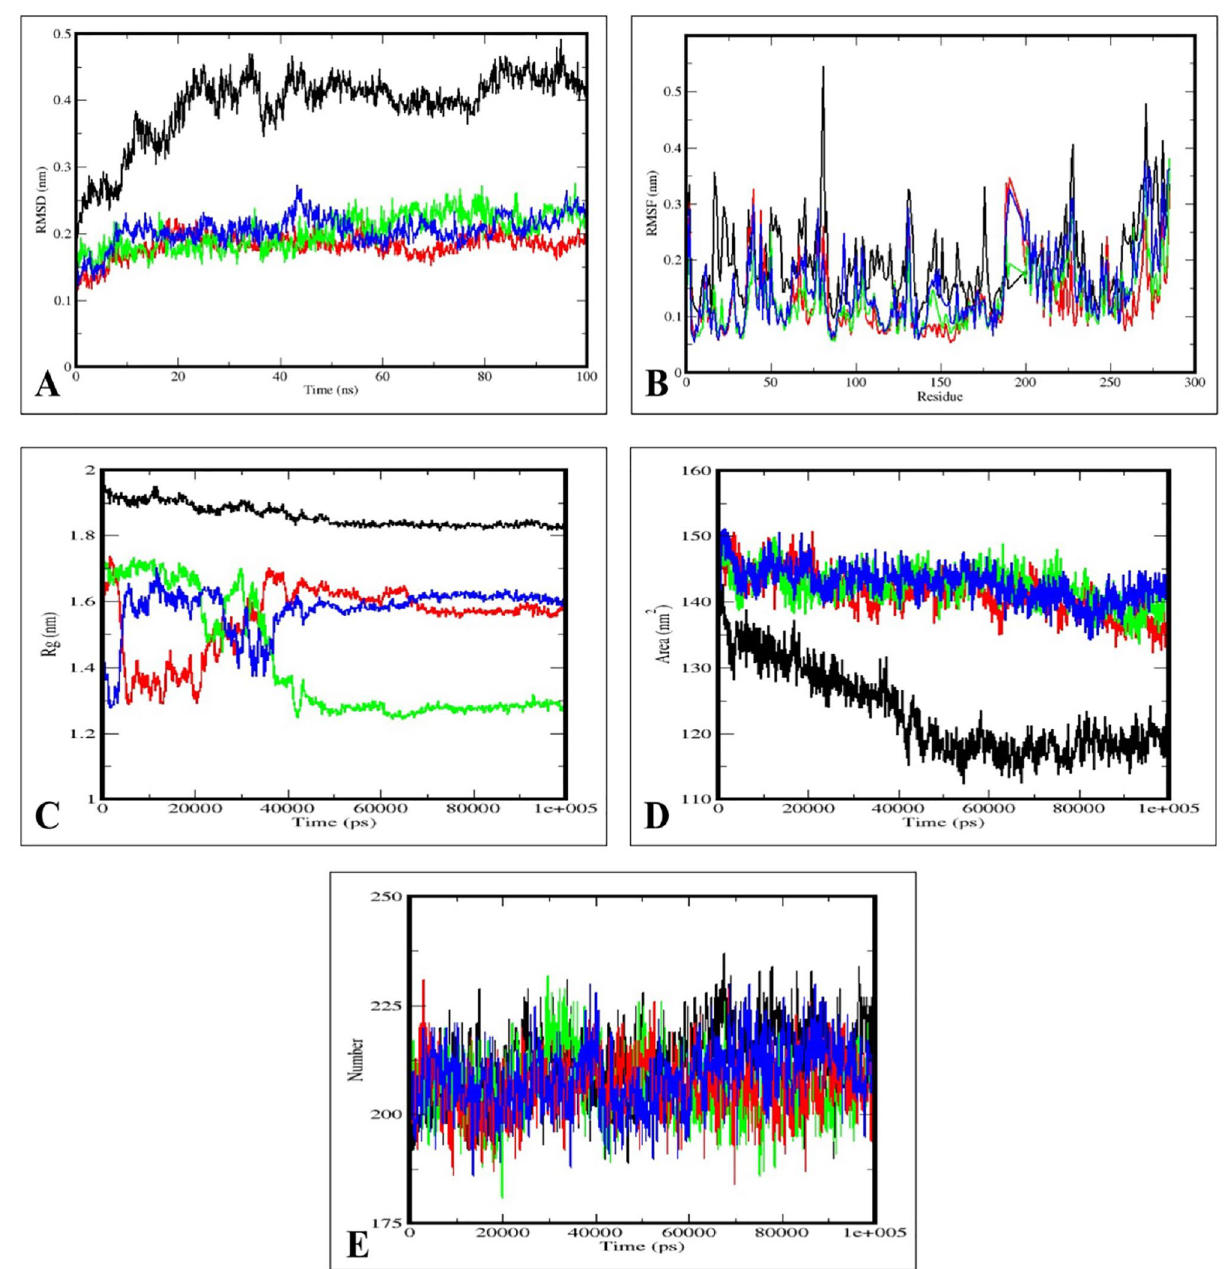
Figure 3. The molecular dynamics simulation trajectories from 100 ns simulation time represents the ( A ) RMSD plot, ( B ) RMSF plot, ( C ) RG plot, ( D ) SASA plot, and ( E ) Hydrogen bond plot (Black: 6CBZ alone, Red: 6CBZ-Altertoxin X complex, Blue: 6CBZ-Cladosporol H complex, and Green: 6CBZ-17 β -Estradiol